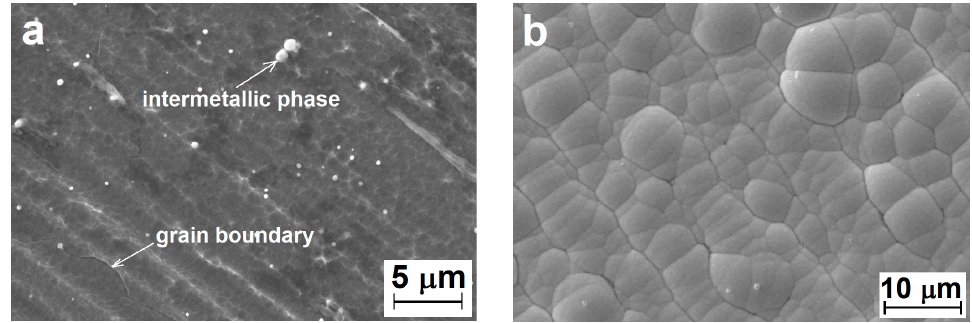
Figure 2. SEM microstructure of the pre-treated substrate and deposited Ni–P coating: ( a ) pre-treated surface of the ZE10 magnesium alloy before deposition; ( b ) fine morphology of the deposited Ni–P coating.